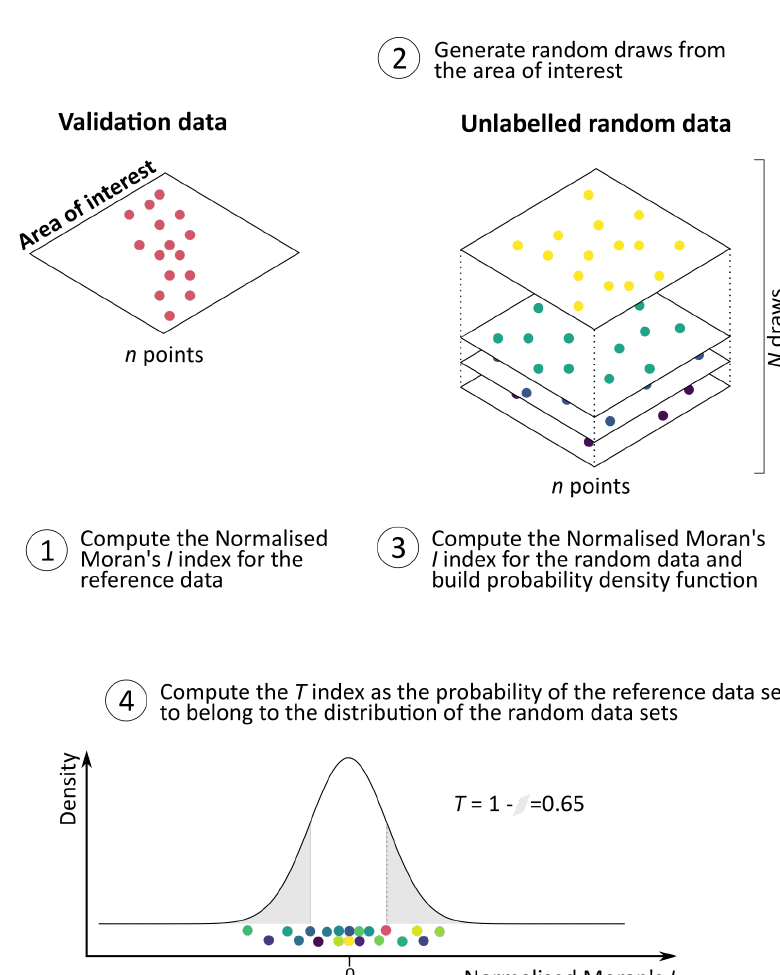
Figure 2. Procedure to construct the T index: (1) calculate the Normalised Moran’s I Index of the labelled hold-out set, (2) generate random unlabelled samples from the map population, (3) calculate the Normalised Moran’s I Index of all random unlabelled samples and (4) compute the probability of the labelled set to belong to the empirical distribution of random unlabelled